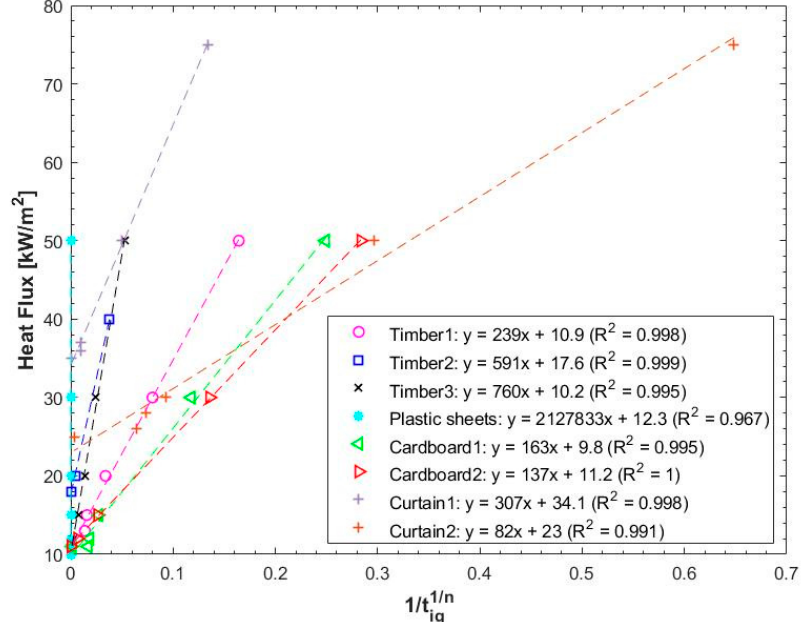
Figure 6. Correlation of ignition times and incident heat flux. t ig is the time-to-ignition in seconds